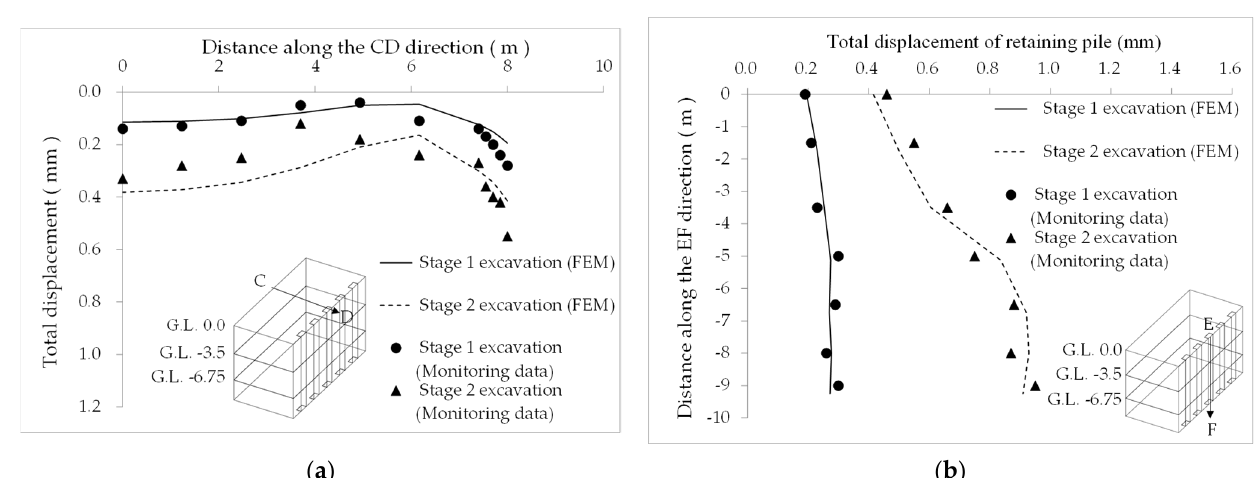
Figure 15. Comparison of the results of the 3D FEM analysis with the inclinometer monitoring data (SID-002) in the retaining piles for the total displacement of the excavation in stages 1 and 2: ( a ) along the CD direction; ( b ) along the EF direction.